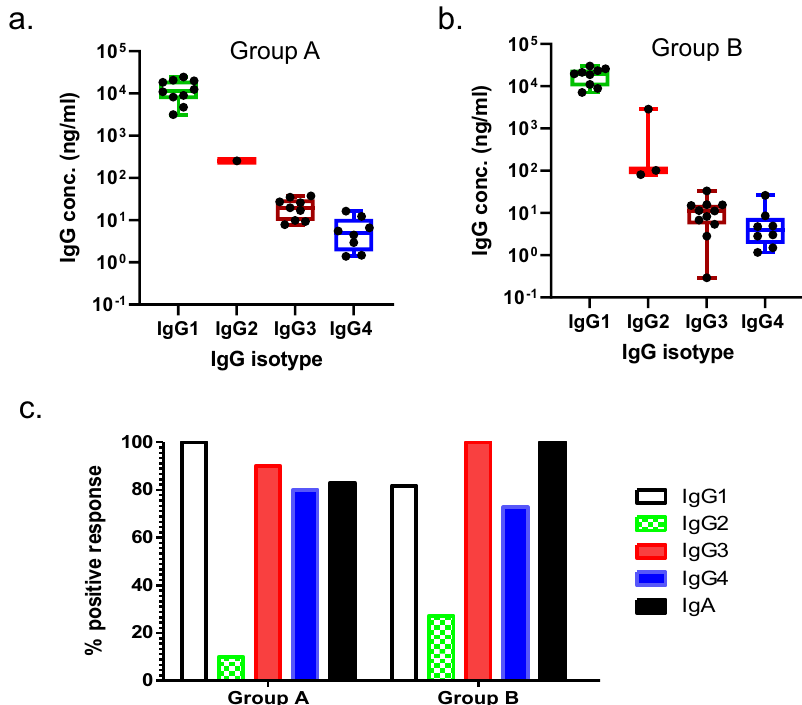
Fig. 1 Env-speci fi c IgG1, IgG2, IgG3 and IgG4 responses in DP6-001 volunteer sera. The magnitude of IgG isotype responses in volunteers receiving the DNA prime vaccine either intradermally ( a ) or intramuscularly ( b ). The response rates against IgG isotypes and IgA in volunteers from Groups A and B ( c